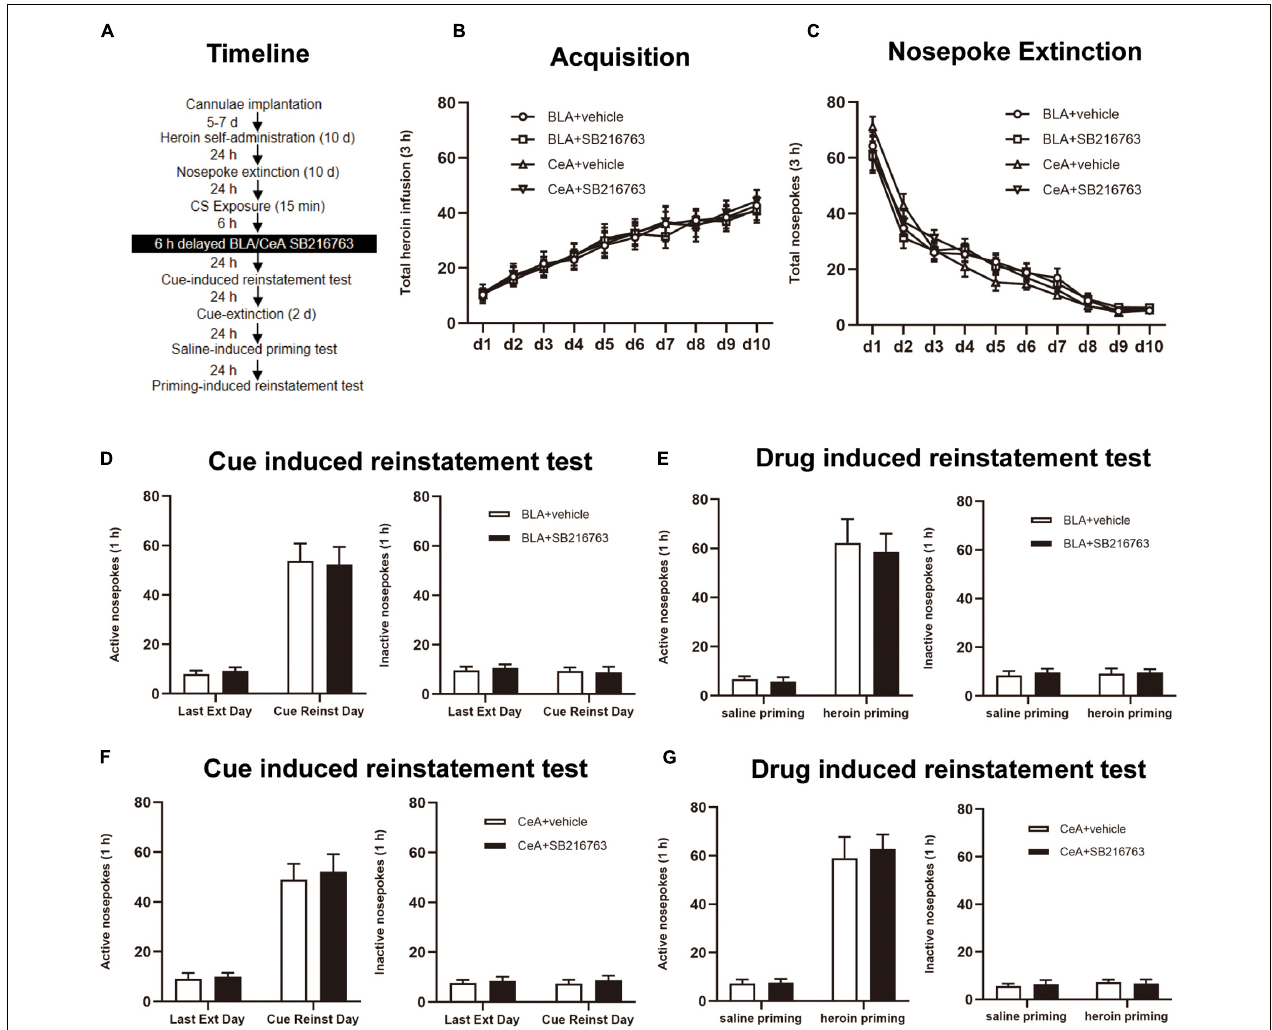
FIGURE 5 | SB216763 treatment 6 h after retrieval does not affect the heroin seeking in the following cue-induced and heroin-primed reinstatement. (A) Timeline of heroin self-administration, nosepoke extinction, cue-induced reinstatement test and drug-induced reinstatement test. (B) Total number of heroin infusions during acquisition of heroin self-administration. (C) Total number of active nosepoke responses during extinction training sessions. (D,F) Active (left) and inactive (right) nosepoke responses during the last extinction training session and the cue-induced reinstatement test. (D) Nosepoke responses of rats with BLA drug injection. (F) Nosepoke responses of rats with CeA drug injection. (E,G) Active (left) and inactive (right) nosepoke responses across the saline- or heroin- primed reinstatement test. (E) Nosepoke responses of rats with BLA drug injection. (G) Nosepoke responses of rats with CeA drug injection. n = 9–10 mice per group. Data are means ± SEM. CS, conditioned stimulus; Ext, extinction; Reinst,